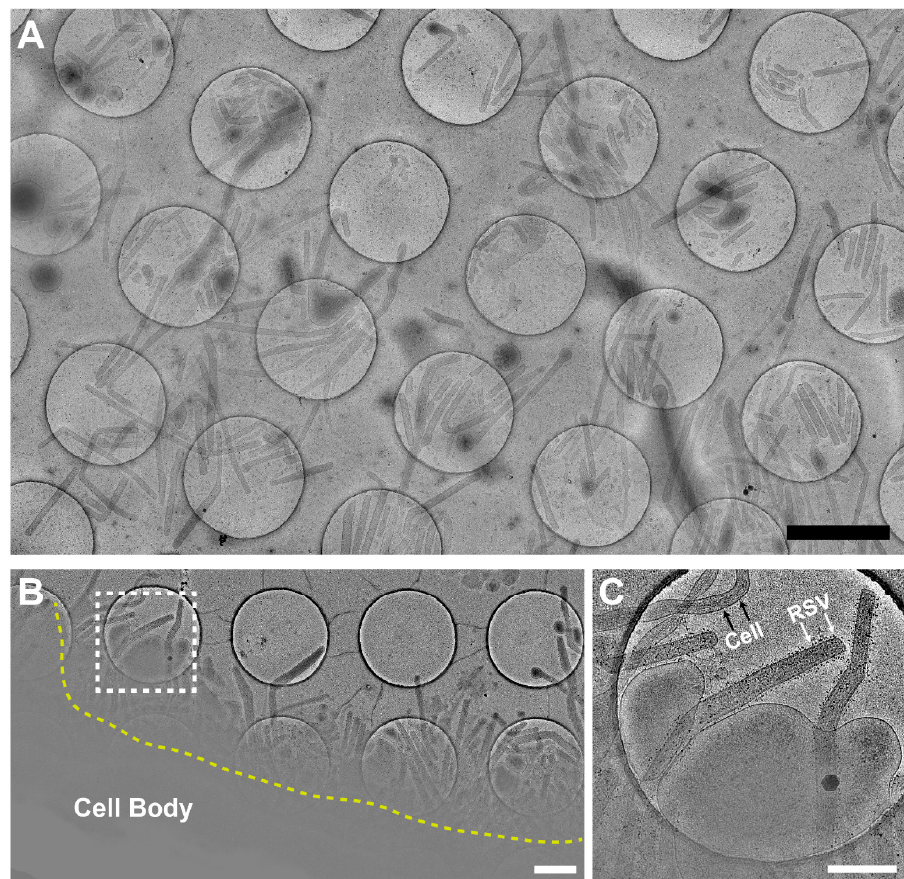
Figure 2. Representative montages showing 2D projections of RSV-infected cells. ( A ) Representative montages showing released viruses from RSV-infected cells. Montage view of released viral particles captured from RSV A2 infected A549 cells. Sample was prepared as described in the method section. RSV morphology varies, with the overall structure being filamentous. Filaments may be straight, bent, or branched. ( B ) Montage view of the assembly site from RSV-infected cells with the F glycoprotein immunogold labeled. The region imaged is an active assembly site, with RSV filaments extending from the cell plasma membrane (dashed yellow line). ( C ) Zoomed-in view of the boxed region in B. Note the presence of 6-nm immunogold on the RSV filaments (white arrows), and the absence of gold particles on cell extension (black arrows). Scale bars are 2 μ m ( A ), 1 μ m ( B ), and 500 nm ( C ).